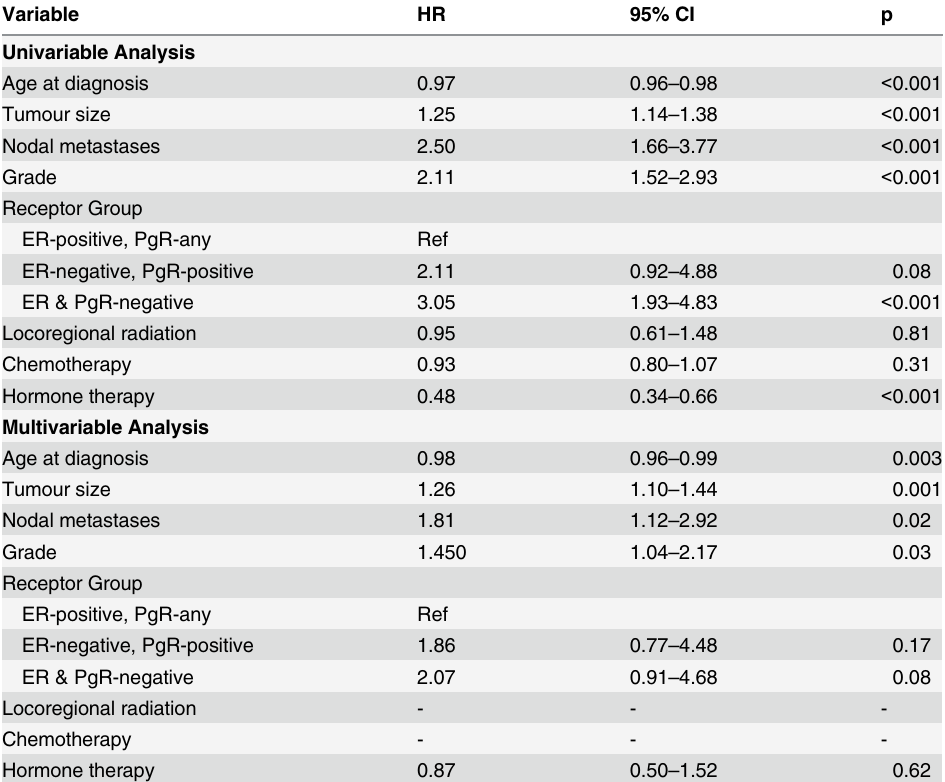
Table 3. Univariable and multivariable analyses for time to relapse in sensitivity analysis excluding patients with HER2-positive disease.